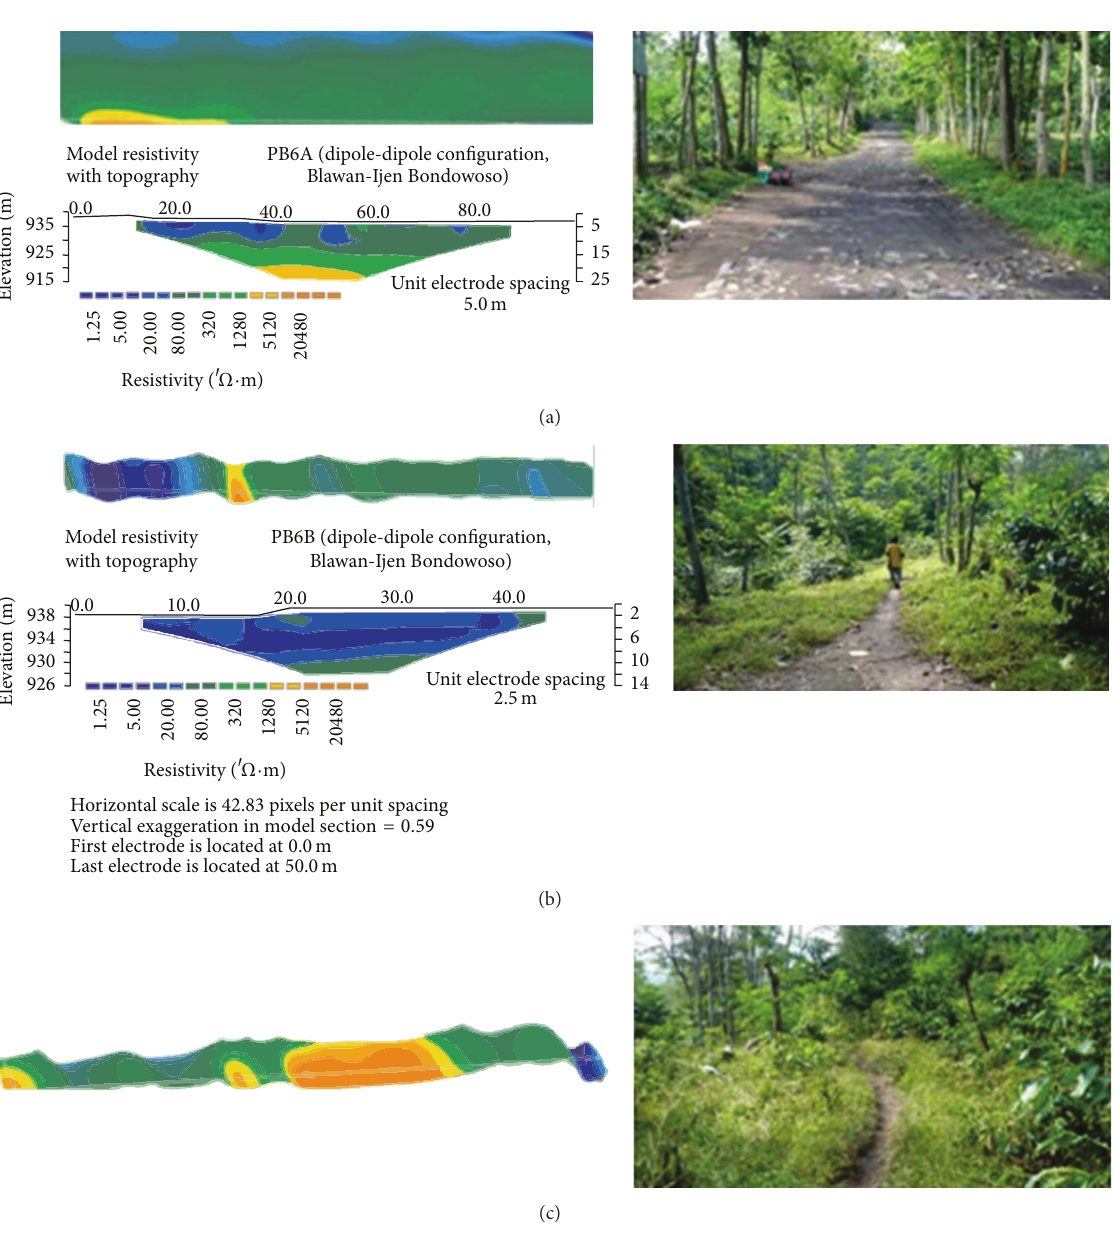
profile with 3 m of thickness. It is estimated that the hot water is towards a lower place in PB4. This assumption is strength- ened by the presence of hot spring in